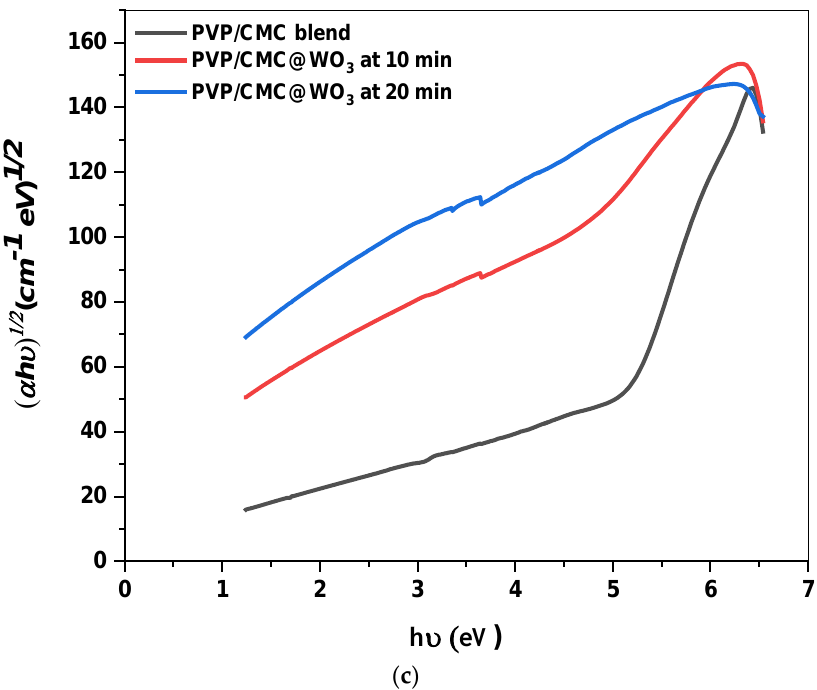
Figure 3. ( a ) Absorption spectrum of PVP/CMC and blend filled with WO 3 at 10 min and 20 min. ( b ) Plot of αhυ 2 versus hυ of PVP/CMC and blend scattered by WO 3 at 10 min and 20 min. ( c ) Plot of αhυ 1/2 versus hυ of PVP/CMC and blend scattered by WO 3 at 10 min and 20 min.